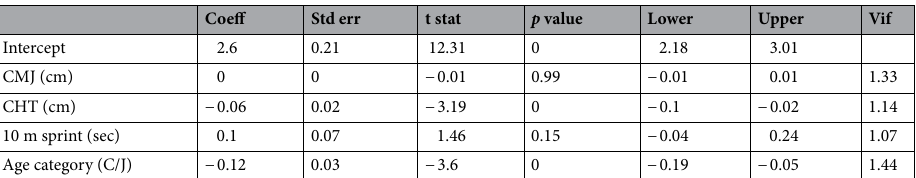
Table 2. Multiple linear regression (dependent variable: 505 test time; independent variable: countermovement jump (CMJ) height, cross-over hop test (CHT) distance; 10 m sprint time (sec) and